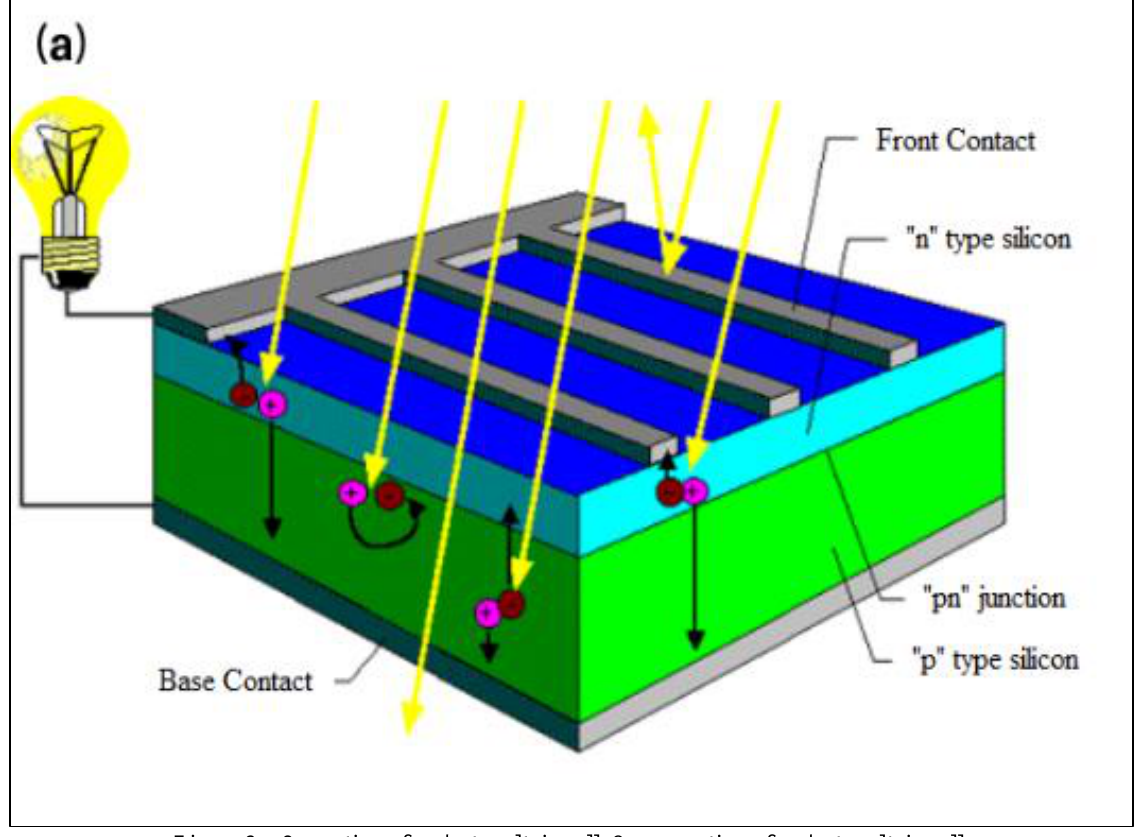
Figure 3a: Operation of a photovoltaic cell. Cross section of a photovoltaic cell. Source: [22].